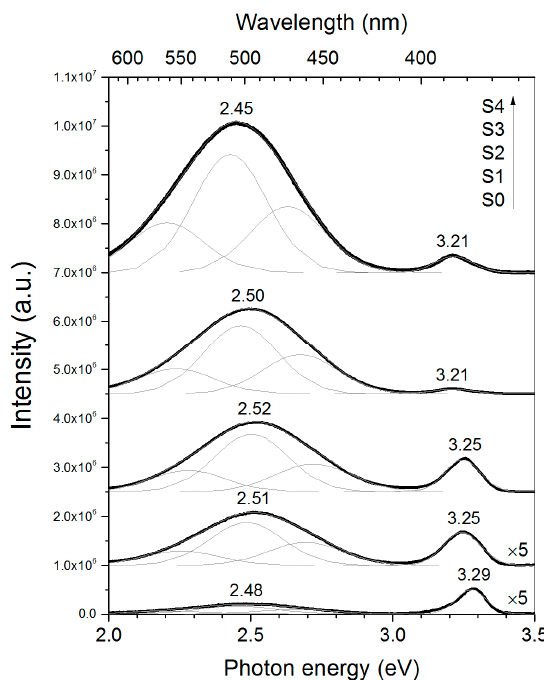
Figure 6. Photoluminescence (PL) spectra of the precursor powder (S0) and the products obtained by its thermal oxidation (900 ° C; air atmosphere) during different times: 3 (S1), 6 (S2), 12 (S3), and 24 min (S4). All the spectra were acquired using 325 nm as excitation wavelength.